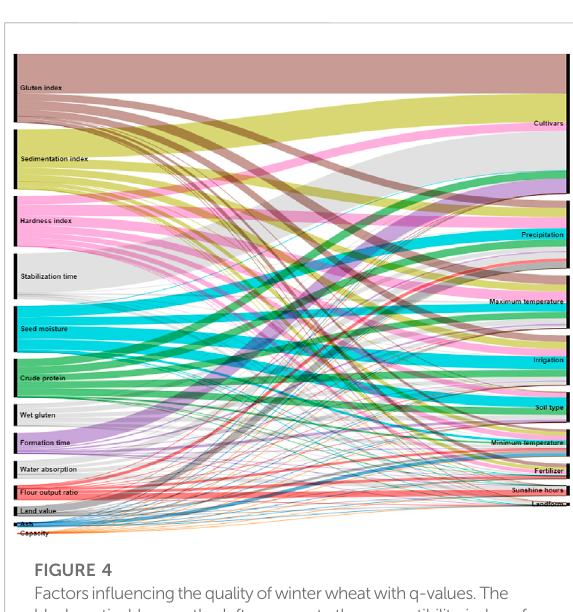
FIGURE 4 Factorsin fl uencingthequalityofwinterwheatwithq-values.The black vertical bar on the left represents the susceptibility index of wheatqualityintheG×E×Mframework.Theblackverticalbaronthe right represents the determination of each driver of wheat